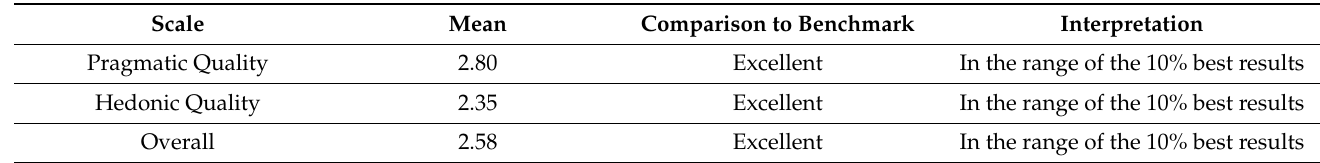
Table 2. Benchmark results for workers’ responses to the